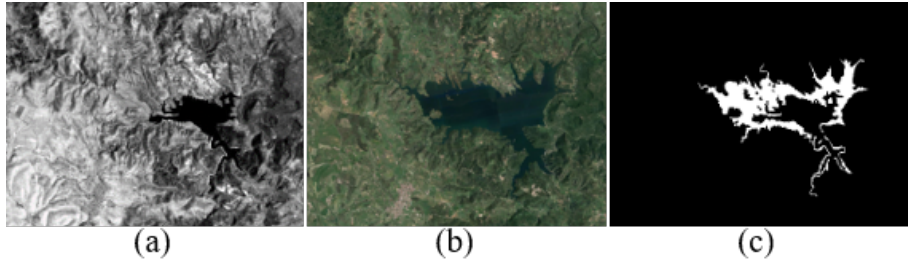
Figure 6. Sardinia dataset. ( a ) Landsat-5 near-infrared image. ( b ) Google Earth optical image. ( c ) Ground-truth.